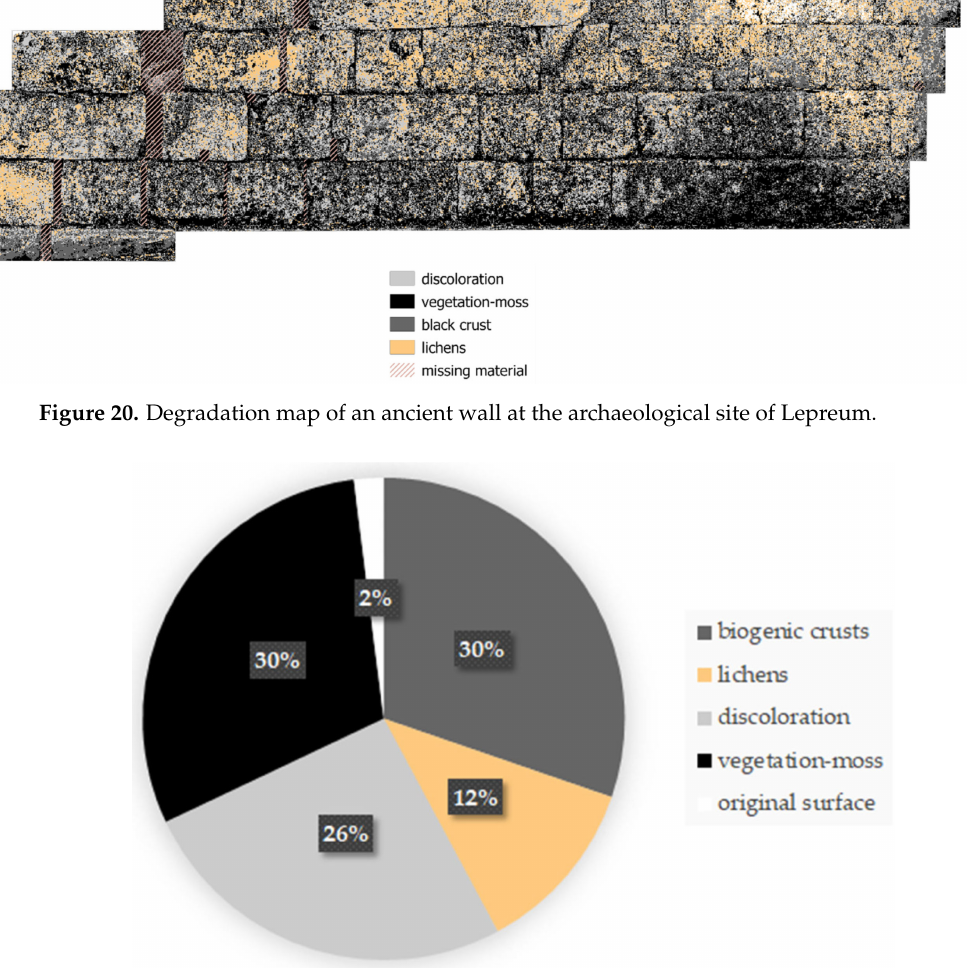
Figure 21. Degradation pattern statistics for the investigated surface of the wall at the archaeological site of